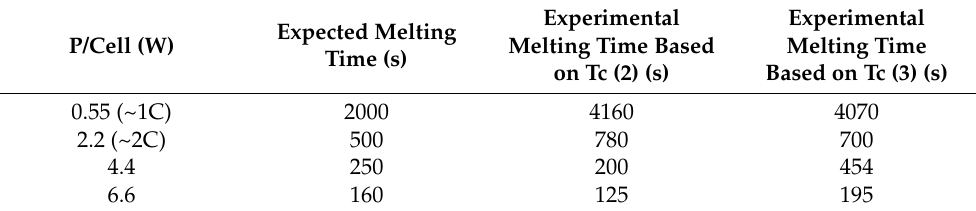
Table 4. Expected and experimental melting times for different thermal